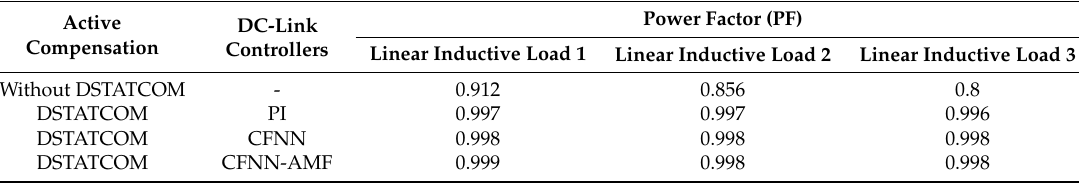
Table 2. PFs without using DSTATCOM and using DSTATCOM with different controllers at linear inductive loads